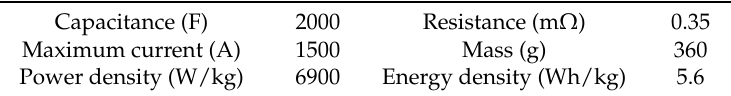
Figure 4. The equivalent circuit model of the UC cell. Table 3. Main parameters of the 2000F UC cell.